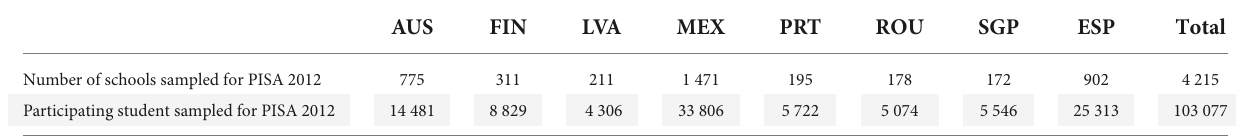
TABLE 3 Overview of the original raw data of and PISA 2012